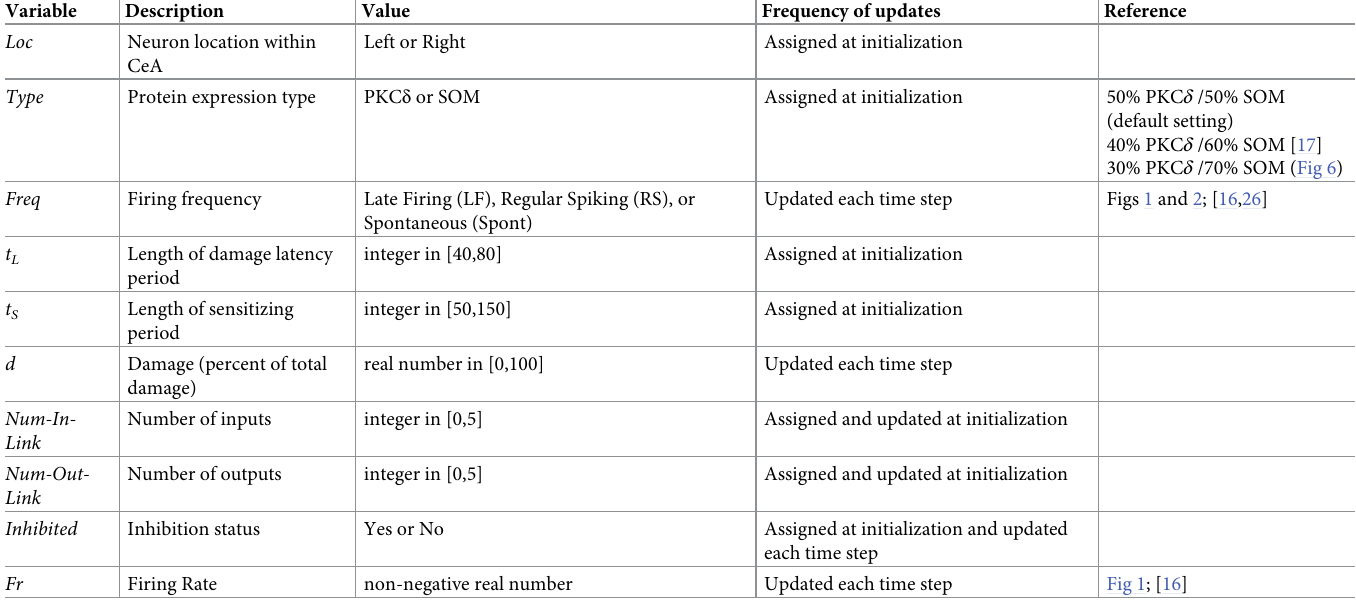
Table 1. Overview of variables assigned to agents representing individual neurons in the ABM. In the instances where the parameter values were estimated from labo- ratory data, the appropriate reference is provided.